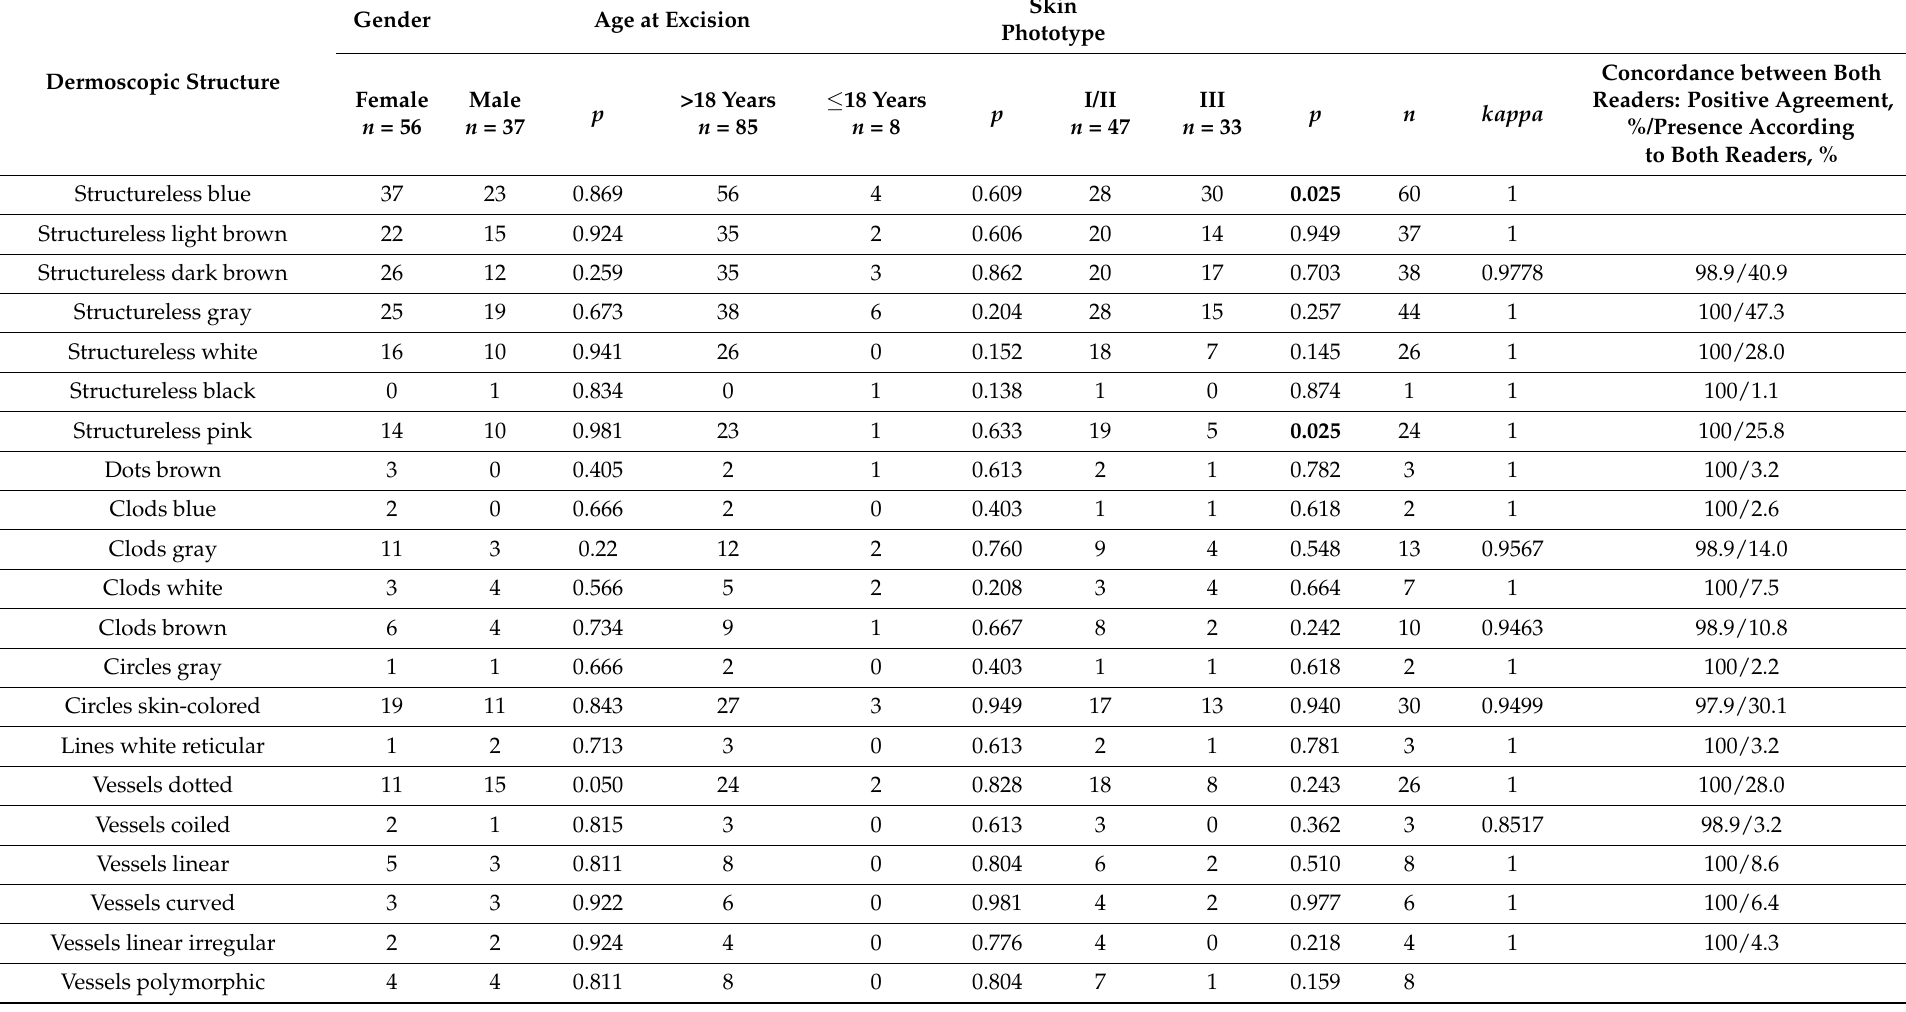
Table 1. The frequency of dermoscopic features in the study group according to the patient-related